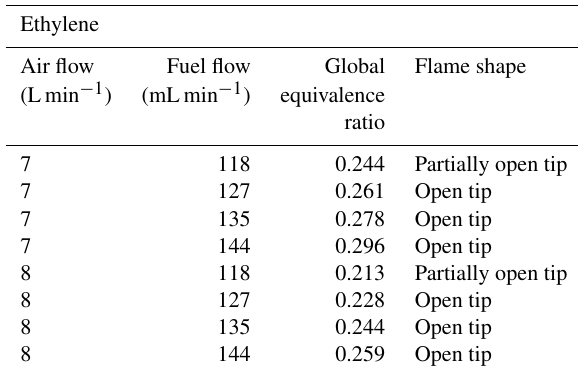
Table 2. Combustion parameters and flame shapes selected for ethy-